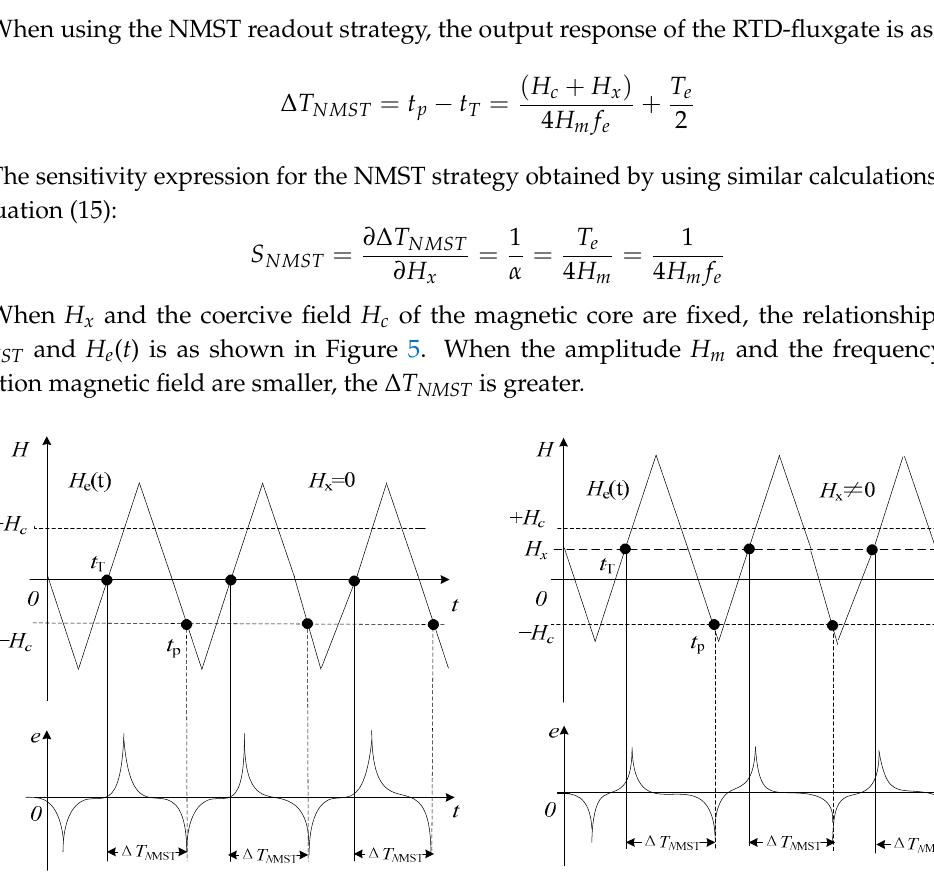
Figure 4. Diagram of the negative magnetic saturation time NMST readout strategy.